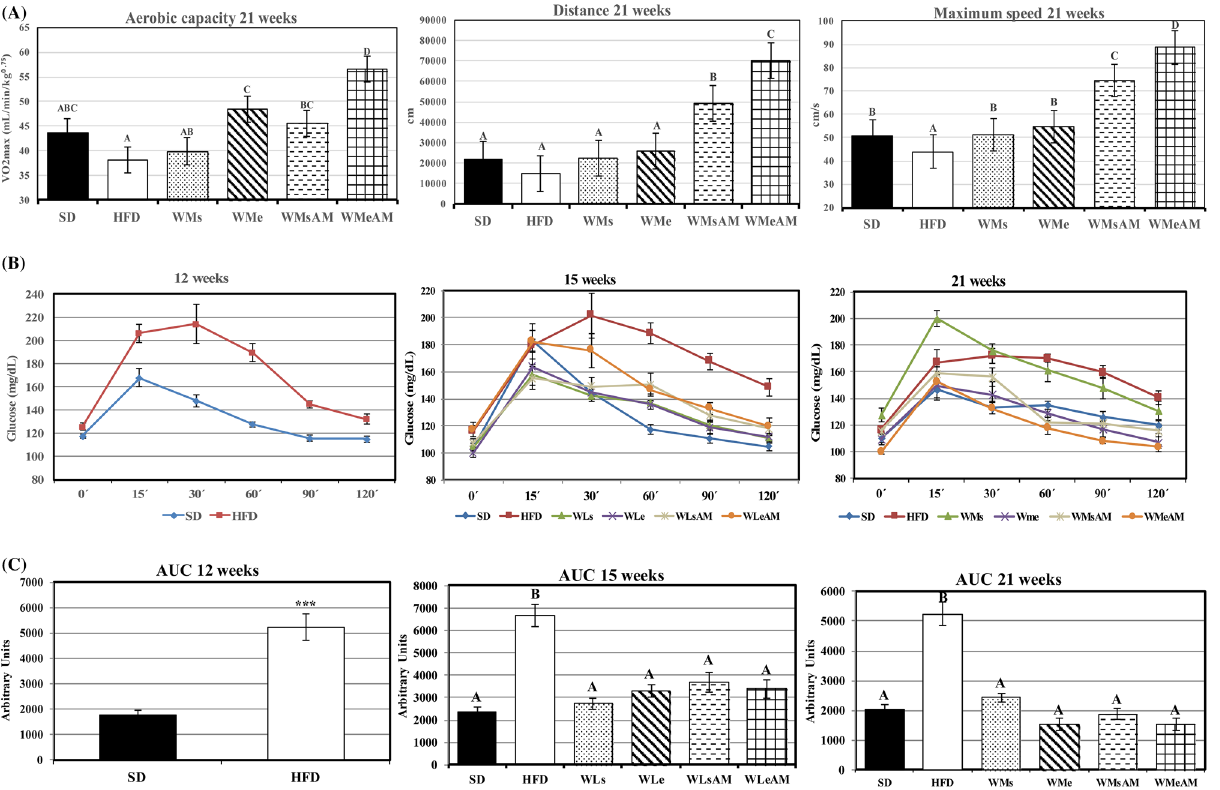
Figure 2. Effects of DIO and weight control interventions on aerobic capacity and glucose metabolism. ( A ) maximal oxygen consumption, maximum speed, and distance run during an incremental test were measured as markers of long term effects after 21 weeks of the experimental period, ( B , C) glycemic profile and area under the curve after an oral glucose overload measured at 12, 15 or 21 weeks of the experimental period. Results are means of eight rats ± SEM depicted by vertical bars. *P < 0.05 in t-test (12 weeks); A,B,C means with different letters are significantly different (ANOVA treatment, P < 0.05; 15 and 21 weeks). AUC area under the curve (arbitrary units), SD normocaloric standard diet group, HFD HFD-treated group. Weight-loss interventions (WL) on weeks 13–15: WLs obese rats treated with caloric restriction and no exercise, WLe obese rats